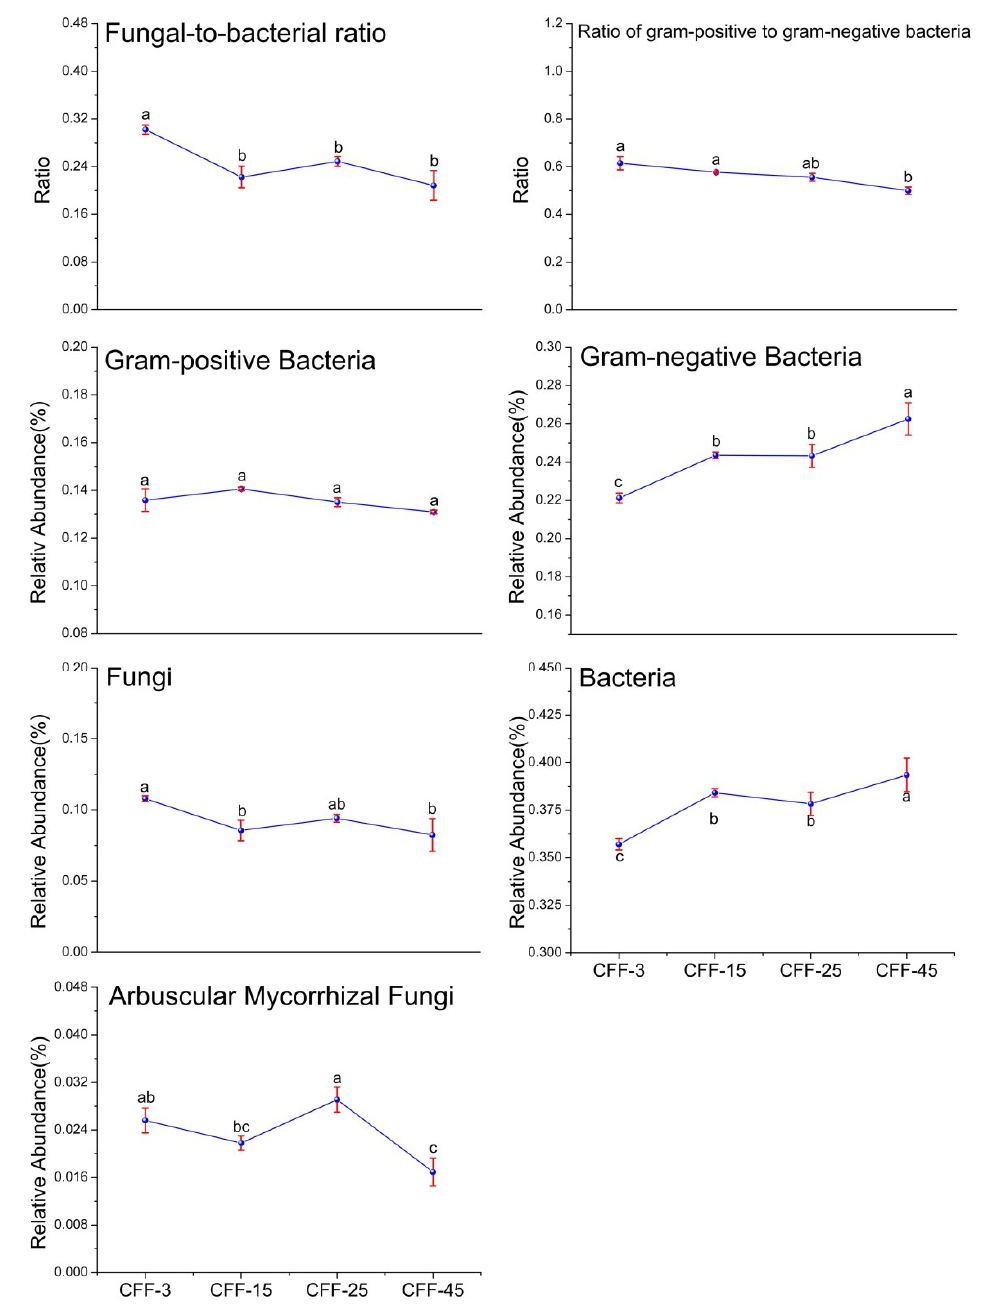
Figure 3. Relative abundance of PLFAs in Chinese fir stands with di ff erent ages in Jiangxi Province. Values are means ( n = 3) with a bidirectional stand error bar. Via Duncan’s multiple comparison test, di ff erent letters in the same columns indicate significant di ff erence among ages. CFF-3, 3-year Chinese fir forests; CFF-15, 15-year Chinese fir forests; CFF-25, 25-year Chinese fir forests; CFF-45, 45-year Chinese fir